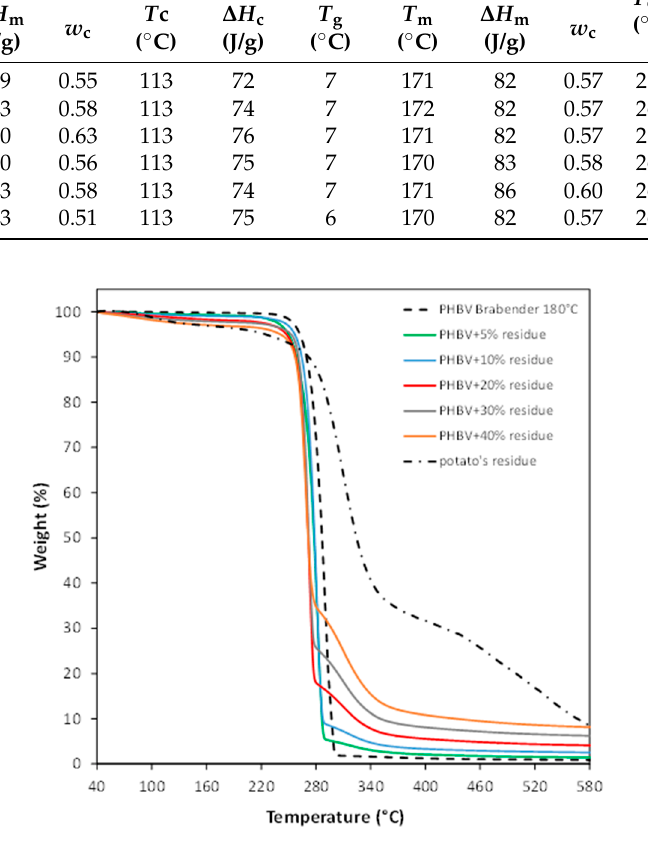
Figure 7. TGA curves of the sweet potato residue, PHBV processed at 180 °C and relative compo- sites.